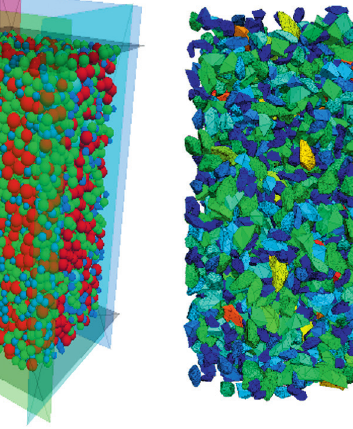
a) particle size >2.36 mm b) particle size <2.36 Figure 7. Model fillings of discrete element specimens